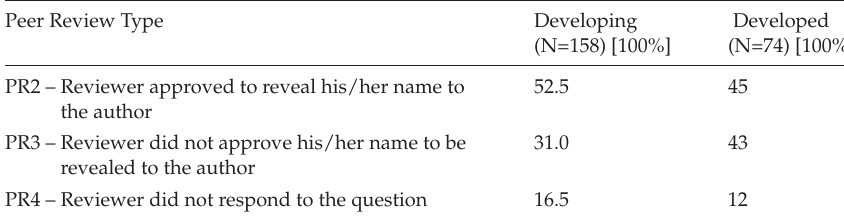
Table 9: Opening identities according the country of reviewers’ institutional affiliation